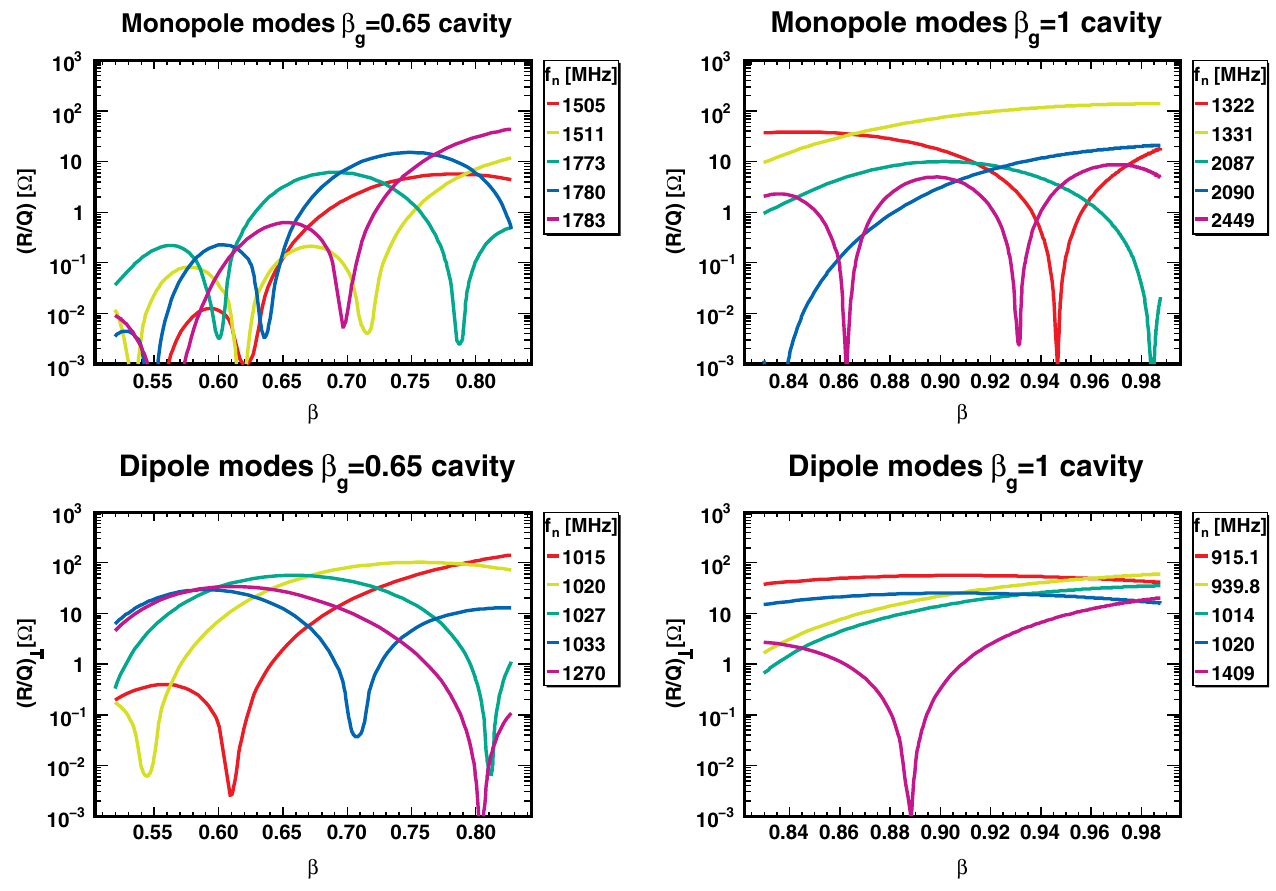
ð (cid:1) Þ maps of the monopoles and dipoles with high ð R=Q Þ FIG. 3. ð R=Q Þ n